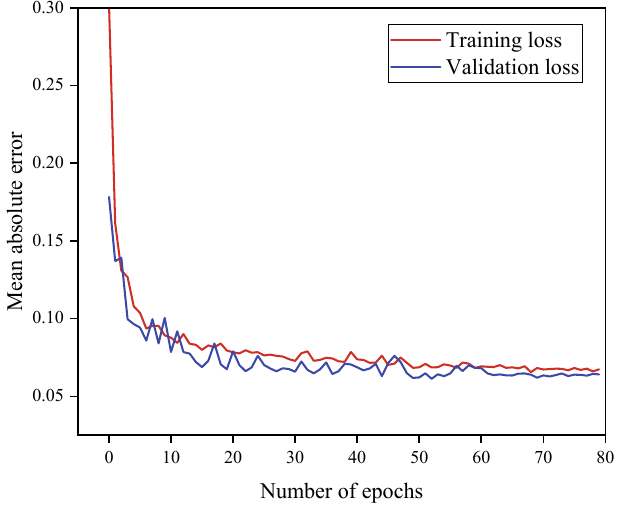
Figure 11. Performance of the model during training and validation error.